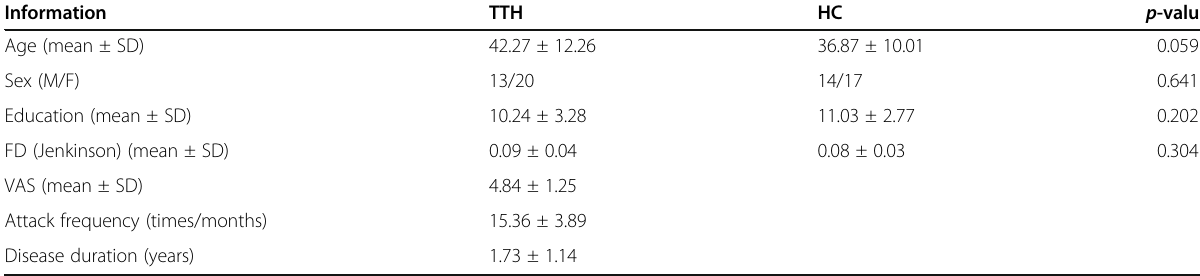
Table.1 Demographic characteristics of tension-type headache patients and healthy controls Information